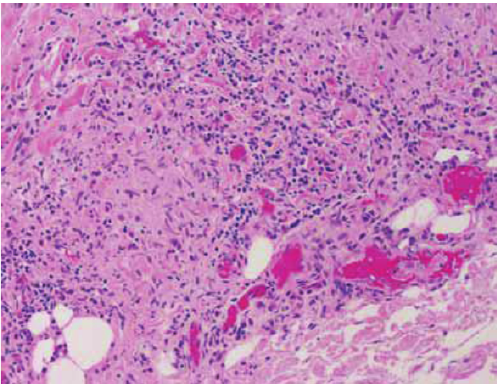
Figure 3: Biopsy of peritoneal nodules showing noncaseating histiocytic